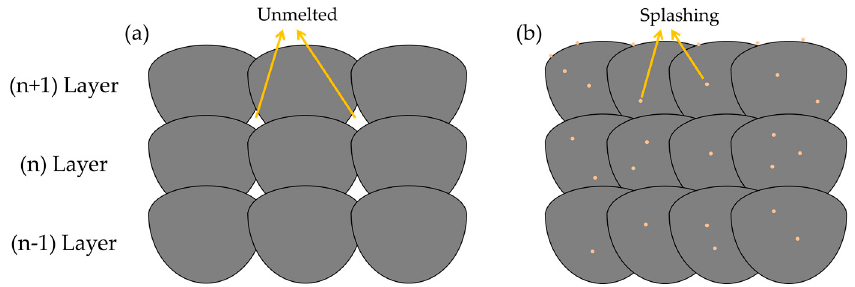
Figure 8. Schematic of selective laser melting (SLM) with ( a ) un-melted defects; ( b ) splashings phenomenon.